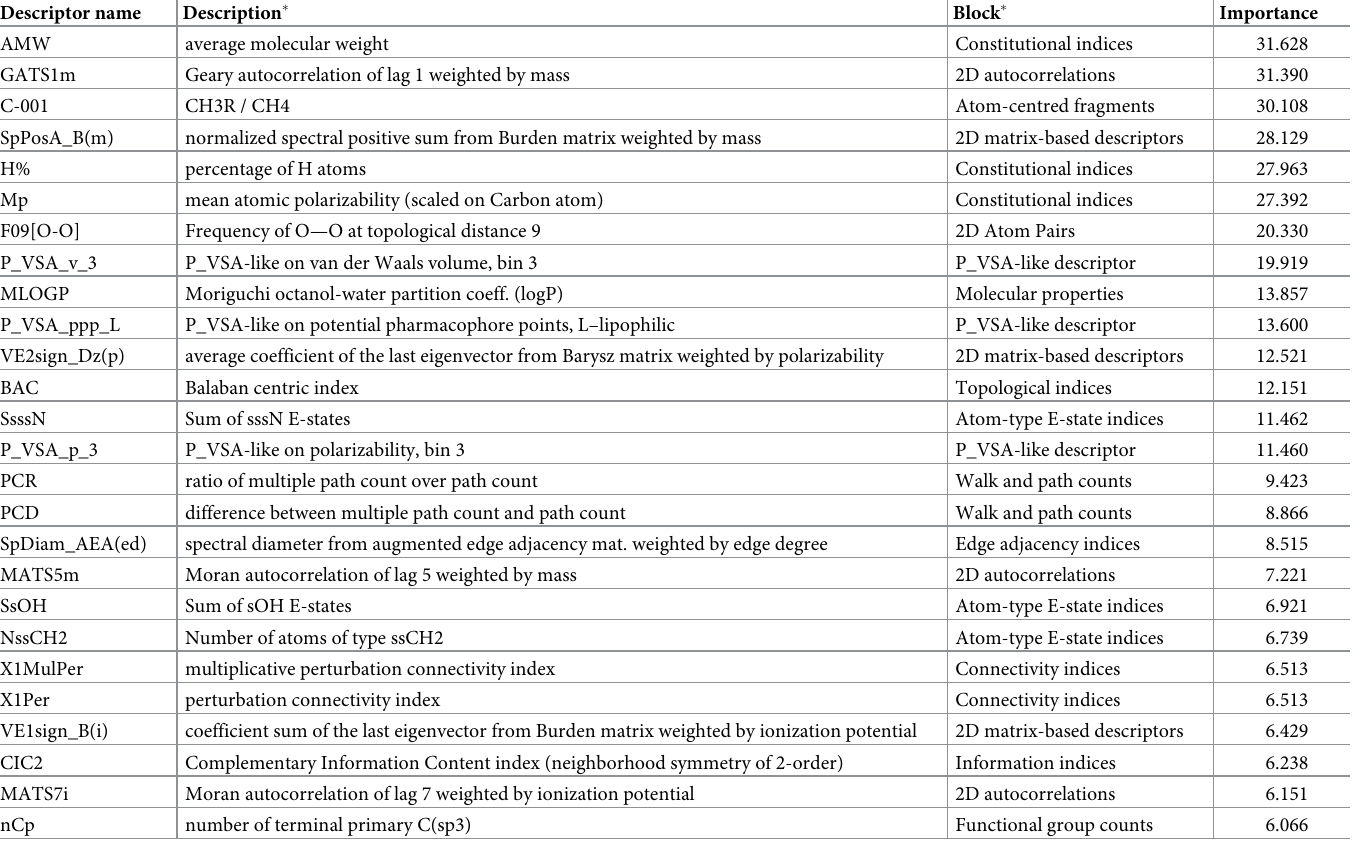
Table 2. The importance values of the descriptors that were used for model